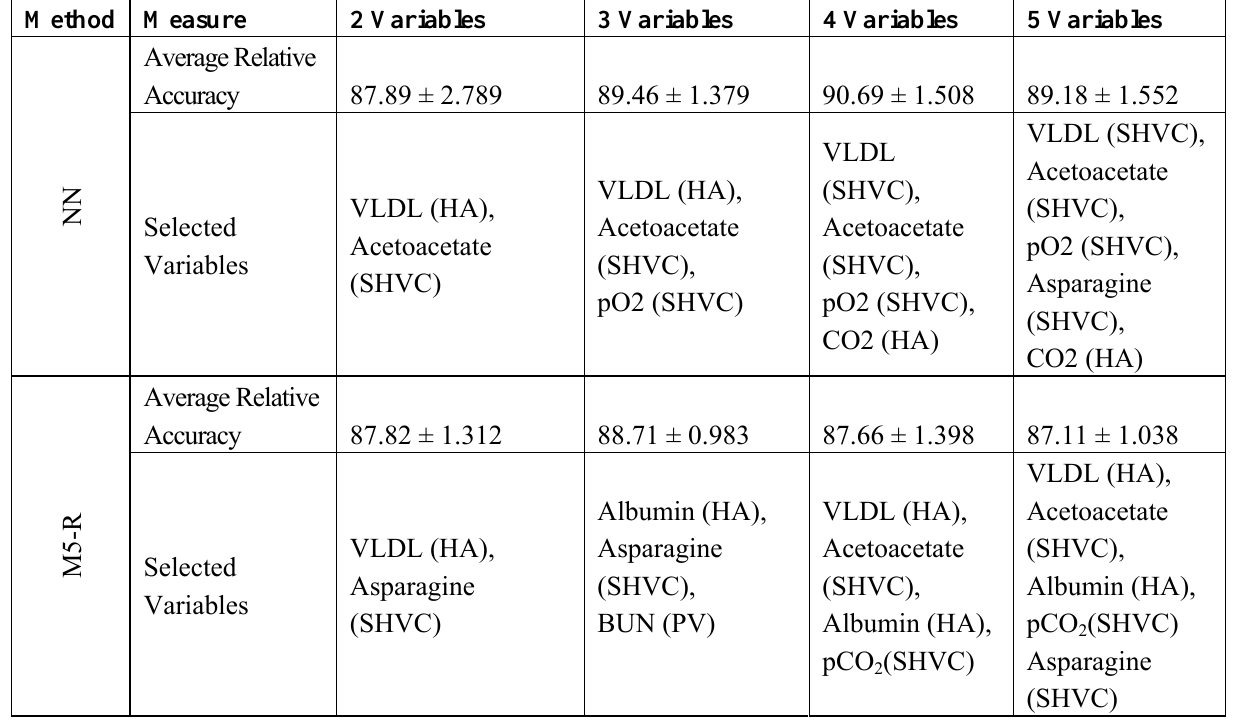
Table 4. Effect of number of variables on regression accuracy.